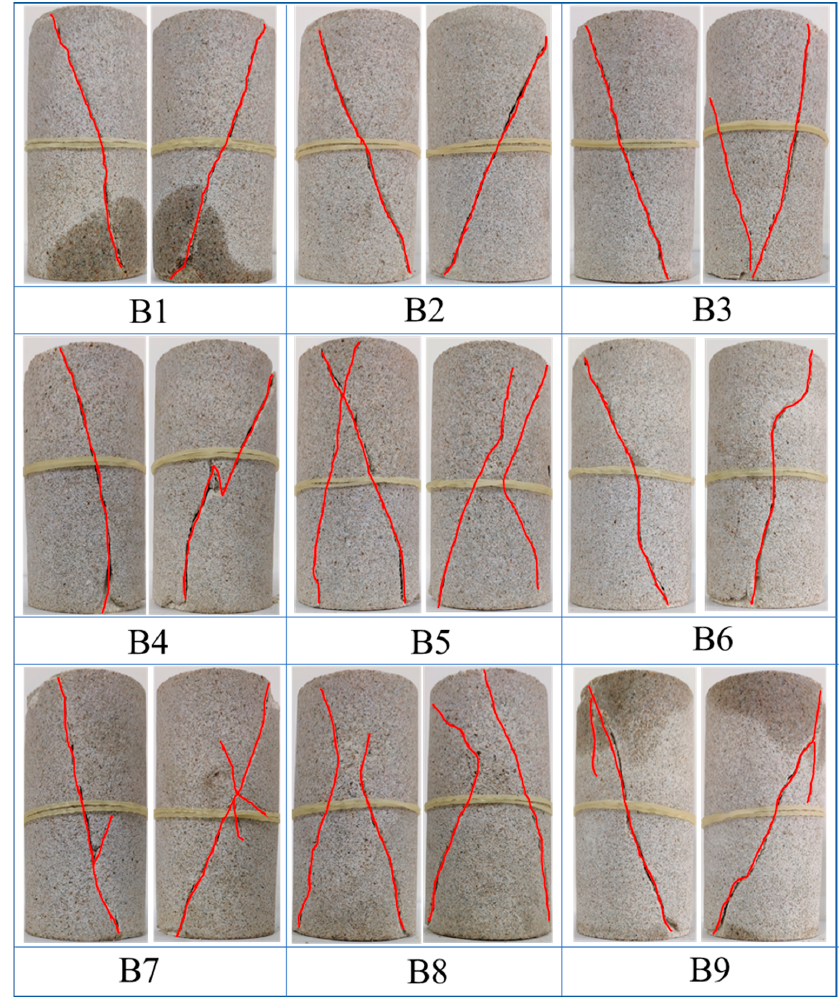
Figure 8. Mining ‐ induced failure characteristics of sandstone. Figure 8. Mining-induced failure characteristics of